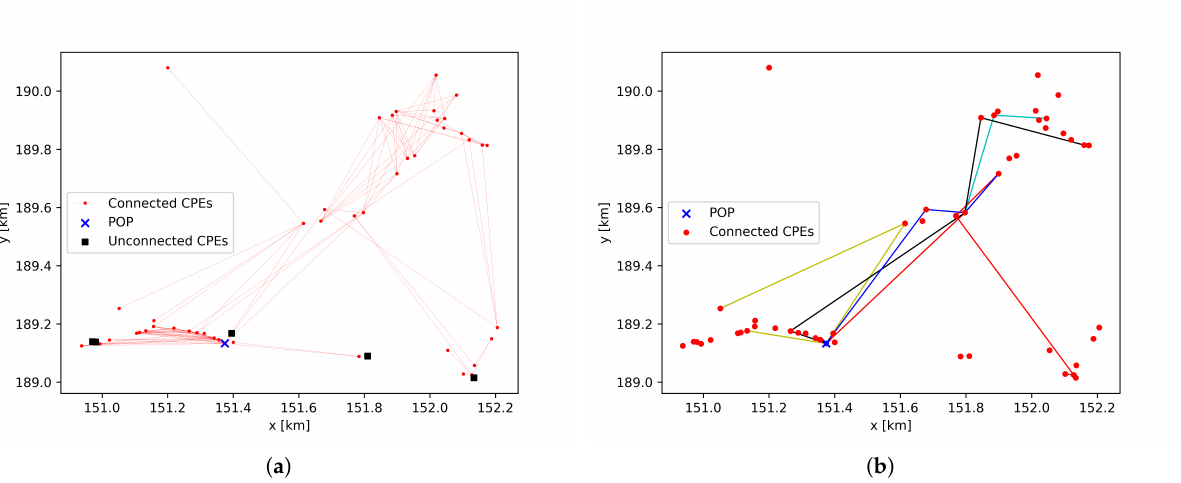
Figure 6. Graph representation and planning of a simulation in rural environment with 50 CPE devices, with the edge colors in ( b ) representing the paths from some CPE devices towards the POP device. ( a ) Graph representation. ( b ) Network